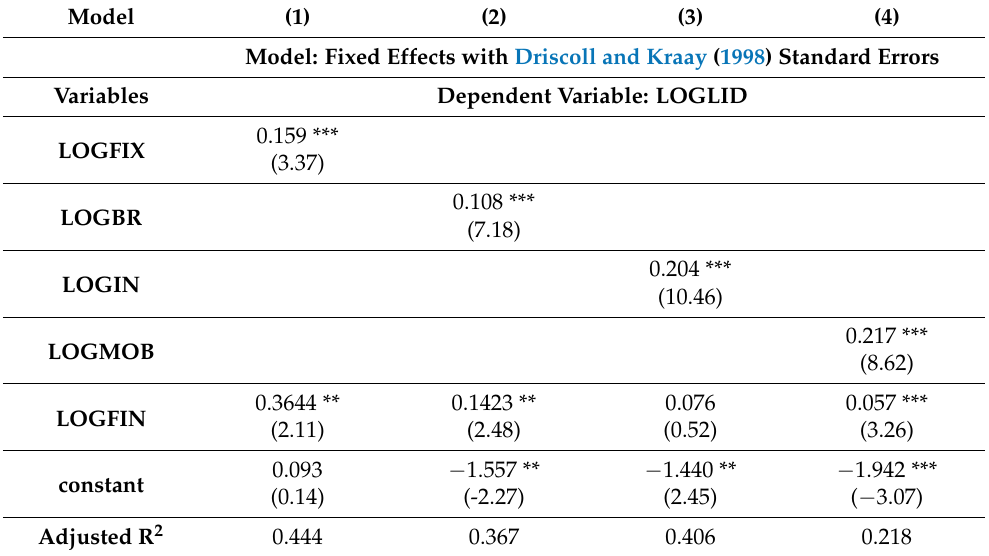
Table 6. Panel regression results.